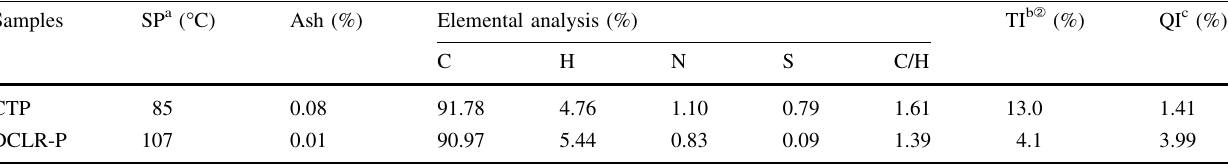
Table 1 Properties of CTP and DCLR-P